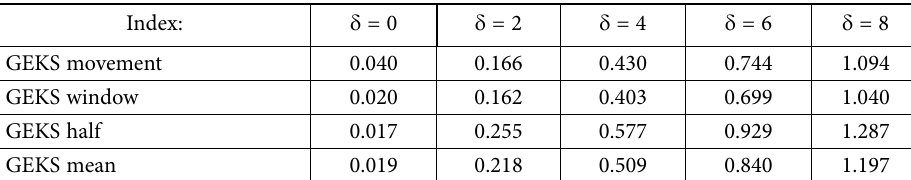
Table 4. Mean absolute distances between considered splice GEKS indices and the target full window GEKS price index (p.p): Case 2